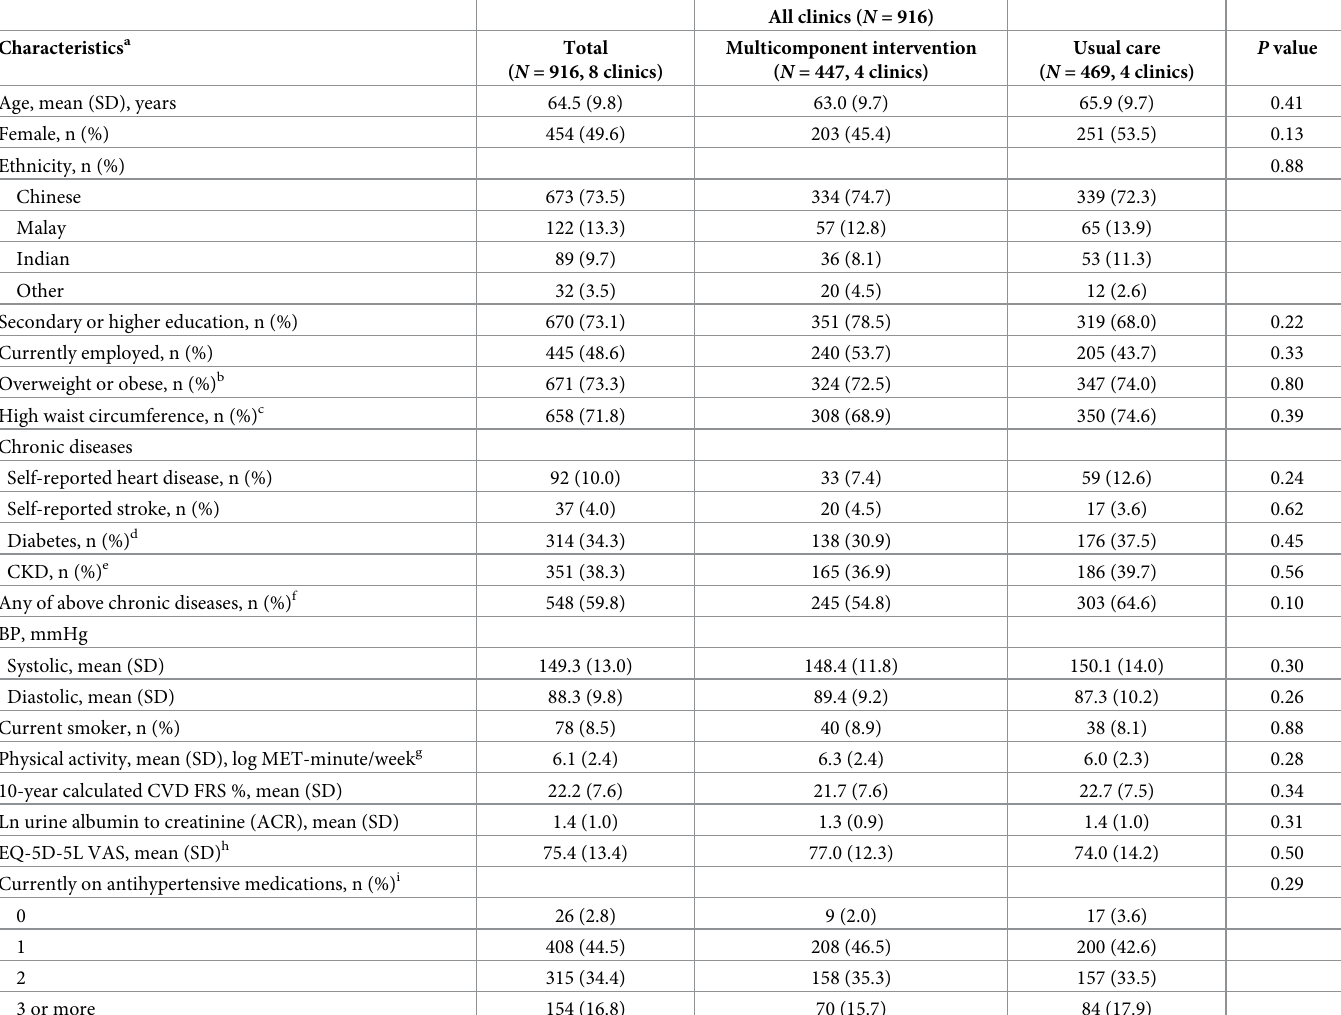
Table 1. Baseline